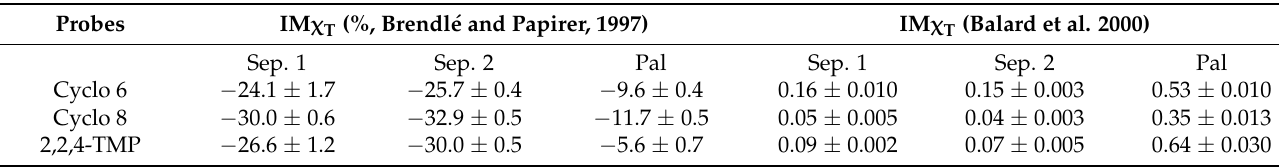
Table 2. Nanomorphology indices ( IM χ T ) , as calculated by two methods, of sepiolite and palygorskite samples at 240 ◦ C. Probes IM χ T (%, Brendl é and Papirer, 1997) IM χ T (Balard et al. 2000) Sep. 1 Sep. 2 Pal Sep. 1 Pal Cyclo